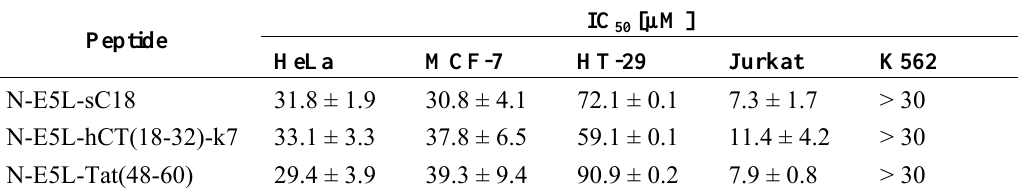
Table 2. IC values of the N-E5L-peptides for the investigated cell 50